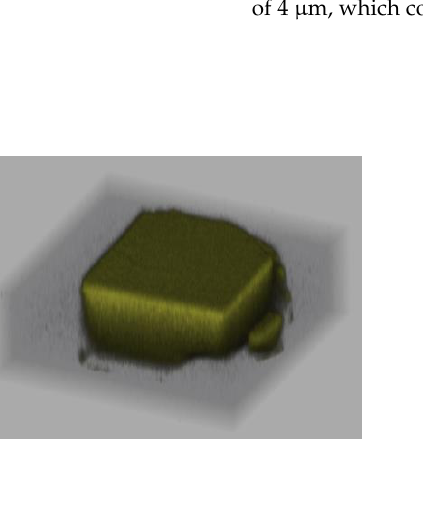
Figure 3. Confocal images of MIA@MOF-5. ( a ) Confocal laser scanning microscopy 3D profile, ( b ) sectional plane at 200 µm from top, and ( c ) stack of sectional planes of MIA@MOF-5 (cw excitation at λ ex = 458 nm, λ em = 530 – 555 nm). Every sectional plane corresponds to a measurement thickness of 4 μm , which corresponds to the optical resolution of the used objective UPLSAPO10X/0.4NA.